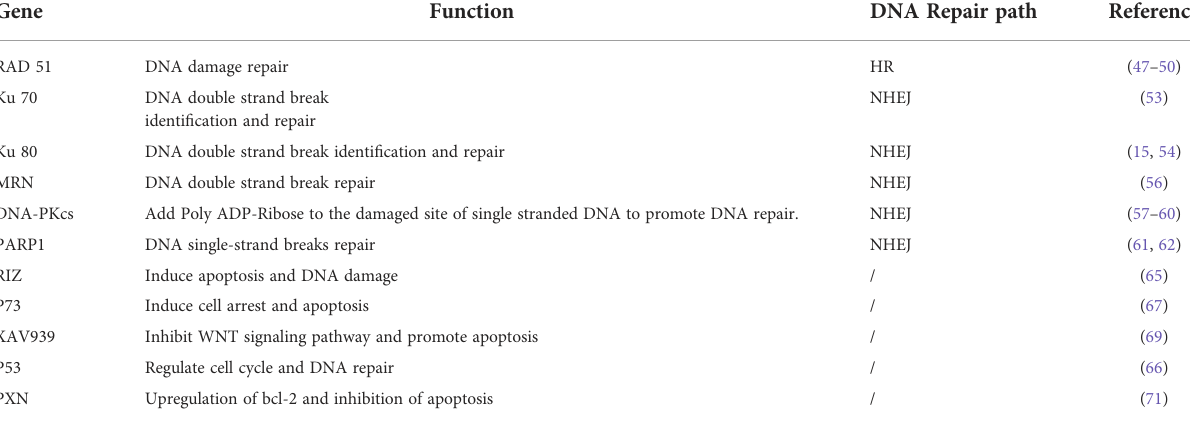
TABLE 1 List of DNA repair molecules and gene regulation in cervical cancer after radiotherapy.